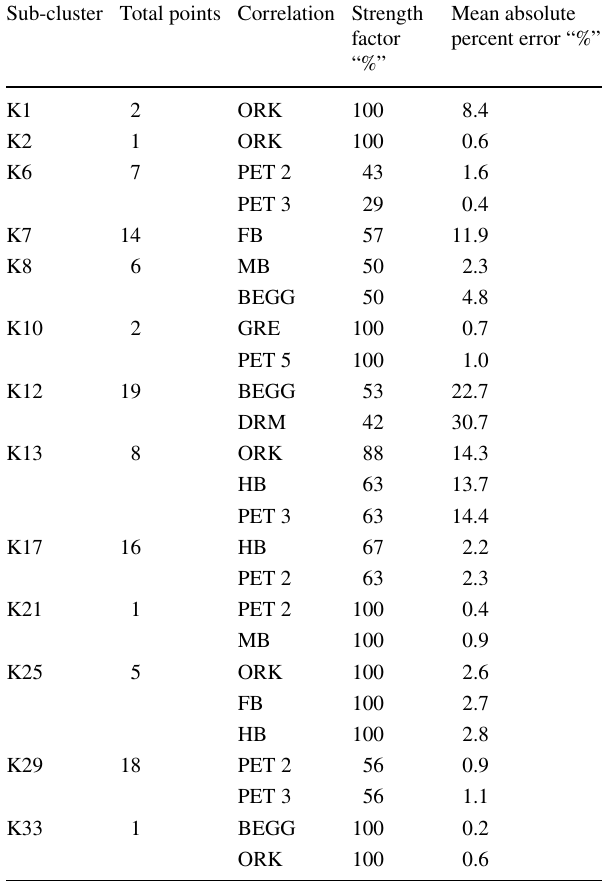
Table 17 Best correlations for cluster (I) Sub-cluster Total points Correlation Strength